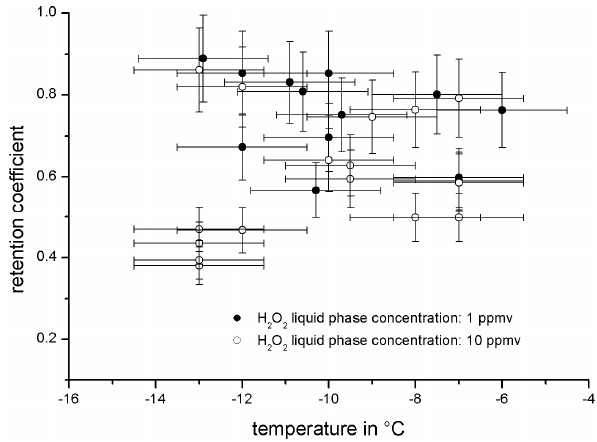
Fig. 5. Retention coefficient of H 2 O 2 as a function of ambient air Figure 5. Retention coefficient of H 2 O 2 as a function of ambient air temperature, determined 2 temperature, determined with captively floating ice particles rimed with captively floating ice particles rimed with solution droplets of two concentrations (black 3 with solution droplets of two concentrations (black circles: 1ppmv, open circles: 10ppmv). circles: 1 ppmv, open circles: 10 ppmv). 4